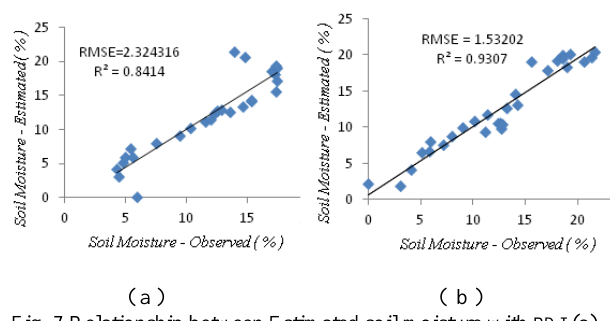
Fig. 7 Relationship between Estimated soil moisture with PDI